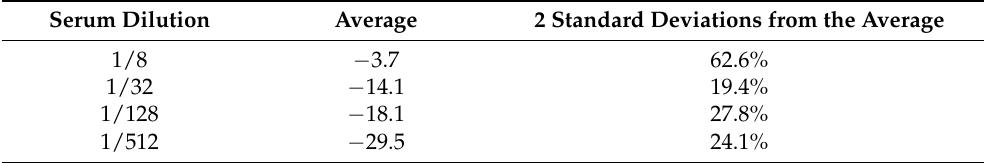
Table 1. Average and standard deviation between 29 non-immune sera tested for their impact on the fusion (expressed in percentage of inhibition). No statistically significant impact of non-immune sera on fusion was